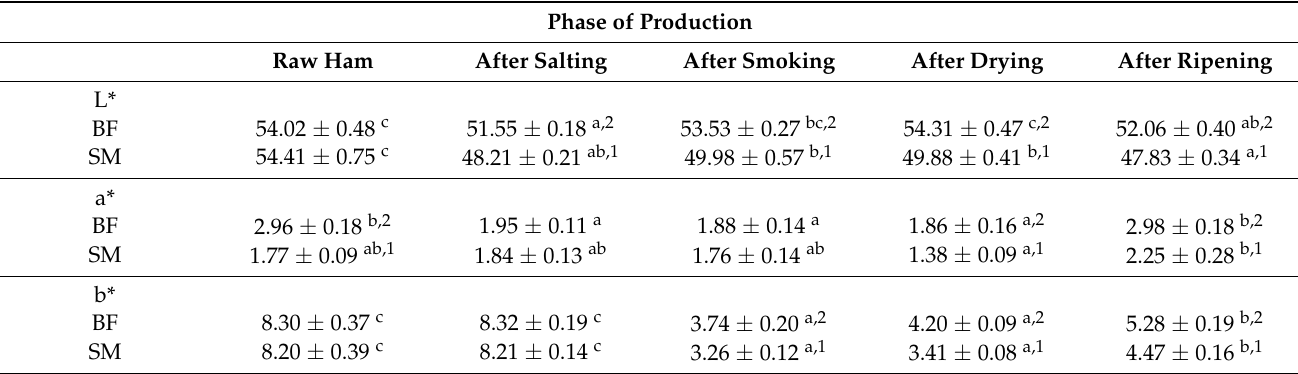
Table 2. Color parameters (L*a*b*) of smoked dry-cured ham in two muscles (biceps femoris (BF) and semimembranosus (SM)) during the manufacturing process (results expressed as mean ± standard error). Phase of Production Raw Ham After Salting After Smoking After Drying After Ripening L* BF 54.02 ± 0.48 c 51.55 ± 0.18 a,2 53.53 ± 0.27 bc,2 54.31 ± 0.47 c,2 52.06 ± 0.40